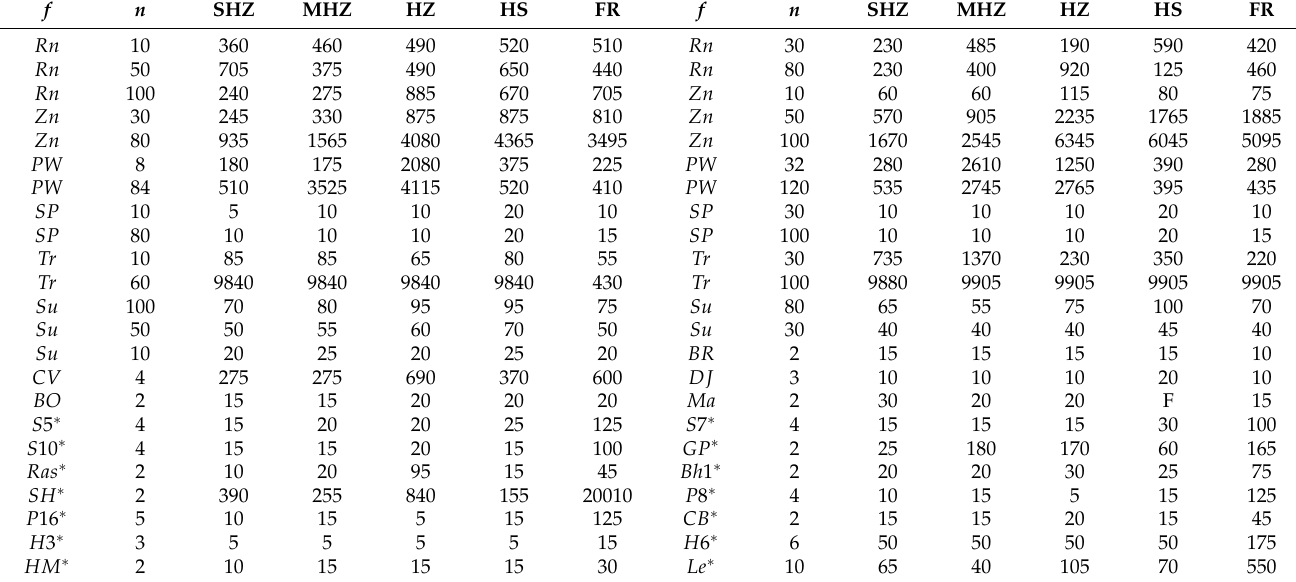
Table 4. The number of best